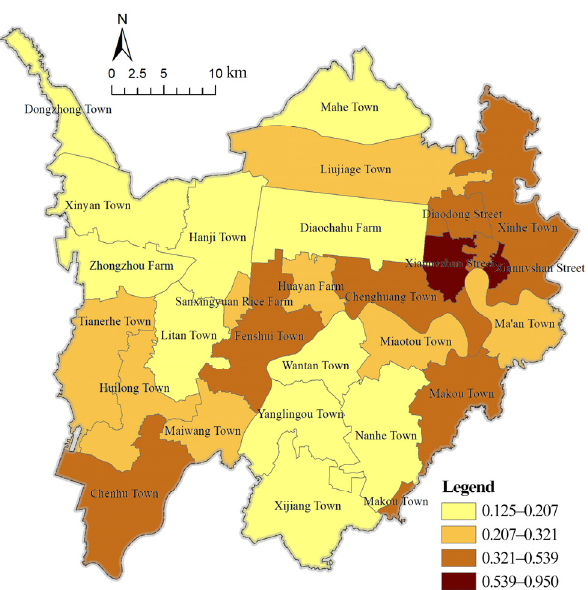
Figure 3. Spatial distribution of current urban–rural integration development level of each town in Hanchuan City.